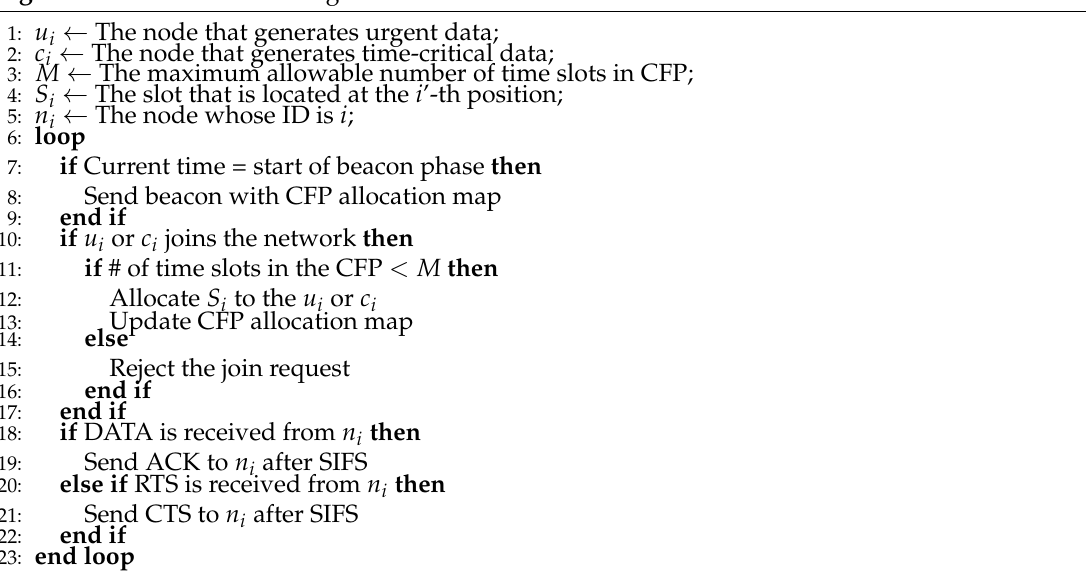
Algorithm 1 The CoR-MAC algorithm for the